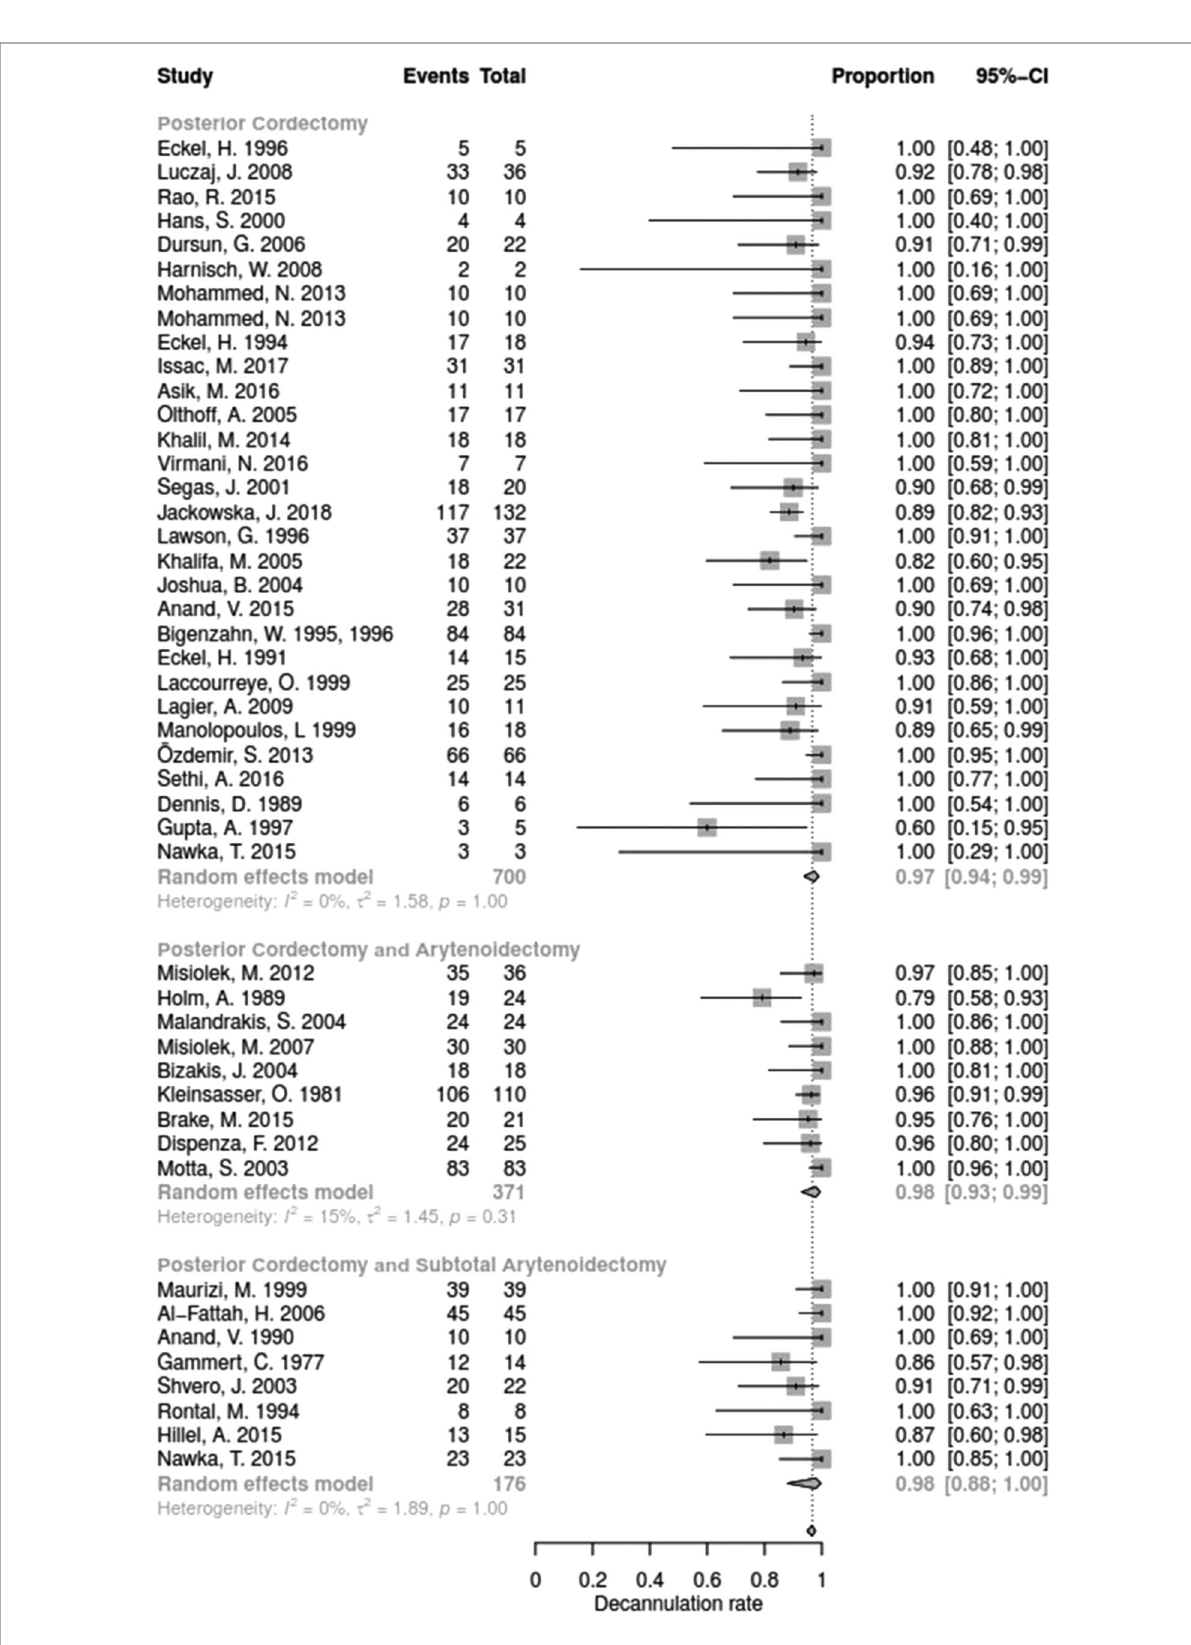
FIGURE 6 Forest plot of decannulation rates in studies on